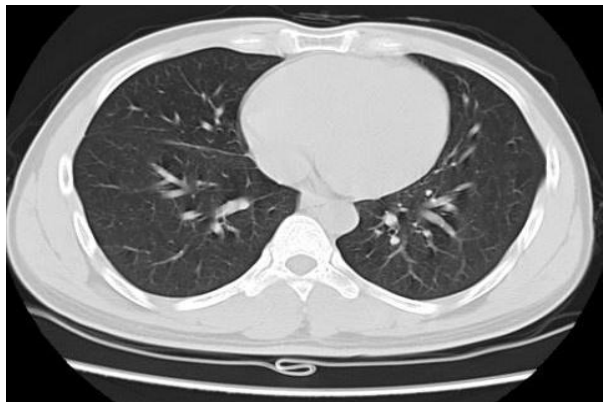
Figure 4: High resolution computed tomography thorax after six months of steroids